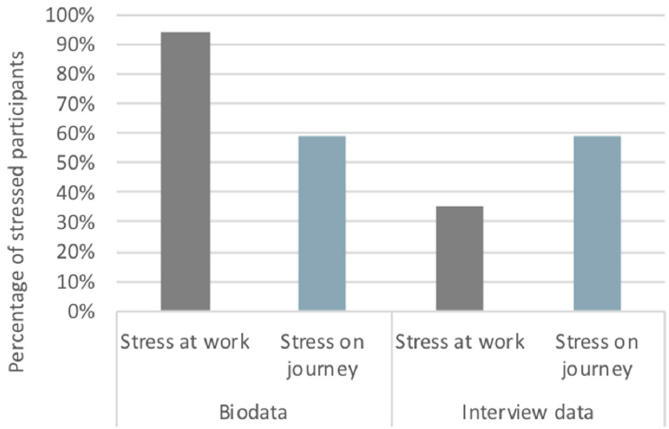
Figure 3. Percentage of participants characterized as “stressed” during journeys and working hours in Birmingham: Physiological measurements (biodata) vs. Interview data.